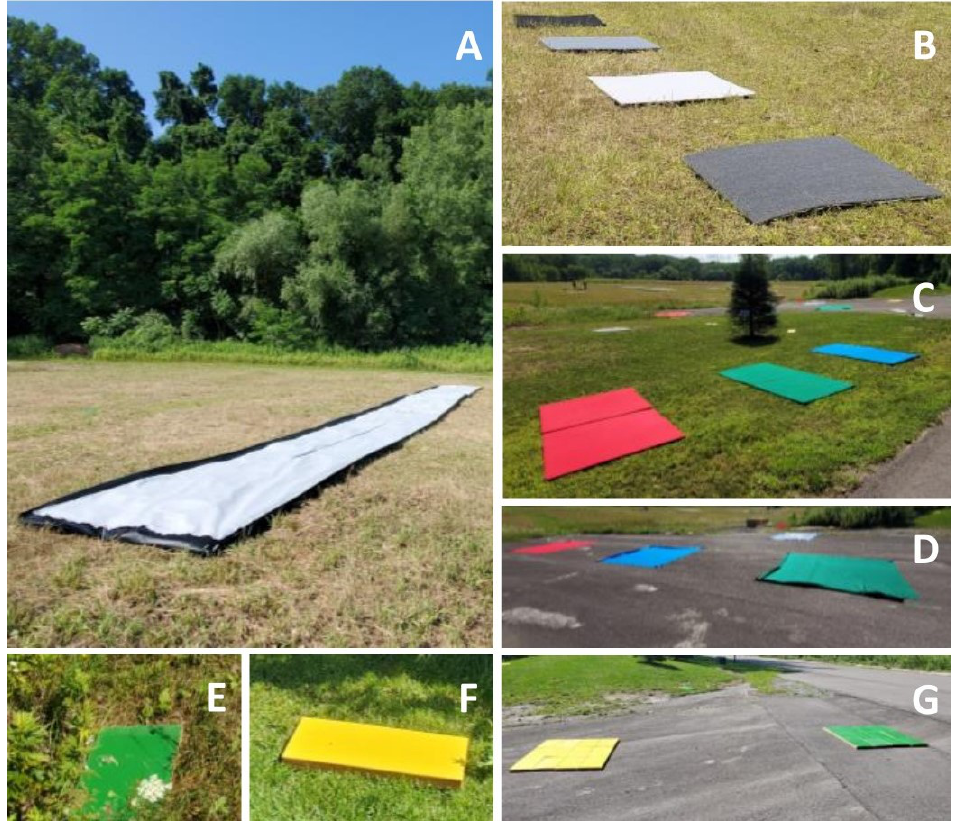
Figure 5. Reflective targets deployed during the G-SCALE included a long, spectrally flat tarp that was used to assess the impact of adjacent trees across the target area ( A ) and grey-scale felt calibration panels ( B ), as well as colored diffuse panels and tarps ( C , D ). In addition to these standards, small green and yellow panels ( E , F ) were distributed throughout the study area at random orientations and locations for spectral target detection and pixel unmixing studies and as large targets ( G ) for endmember